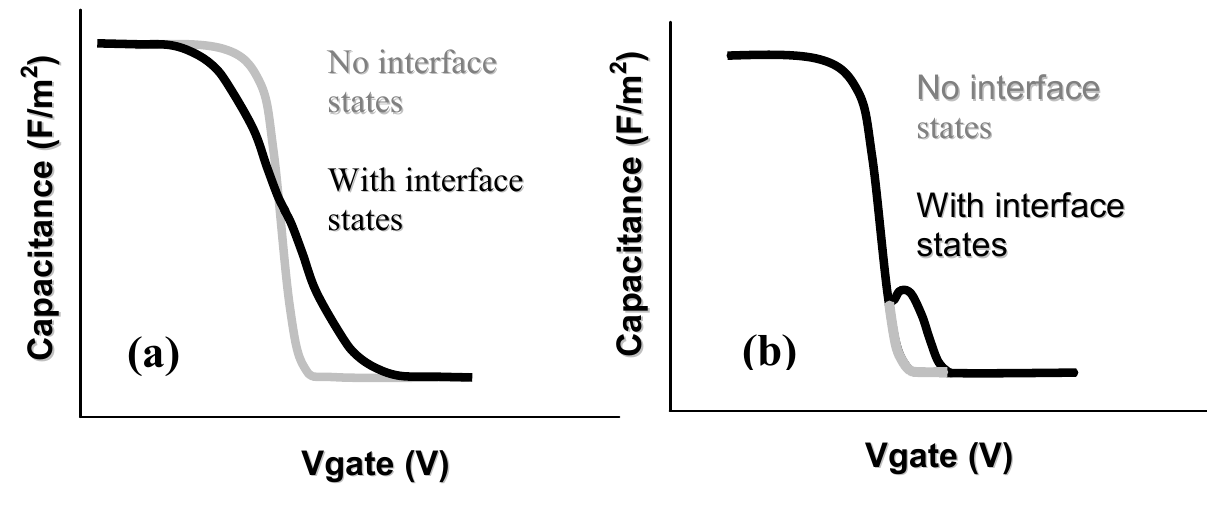
Figure 7. Ideal capacitance voltage profiles for a p-type semiconductor comparing